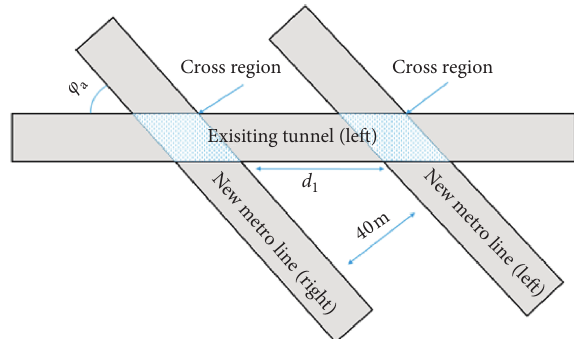
Figure 11: Plan view of the new tunnel and the existing